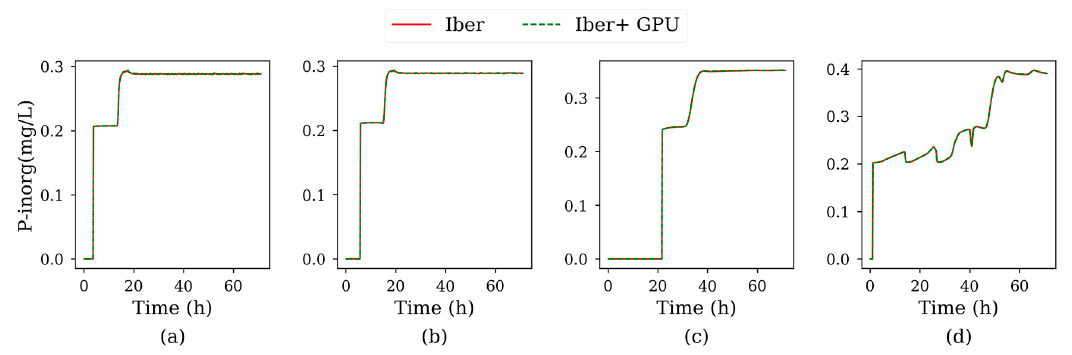
Figure A9. Time series of inorganic phosphorus for Test 4, sampled at control points P1 ( a ), P2 ( b ), P3 ( c ) and P4 ( d ).